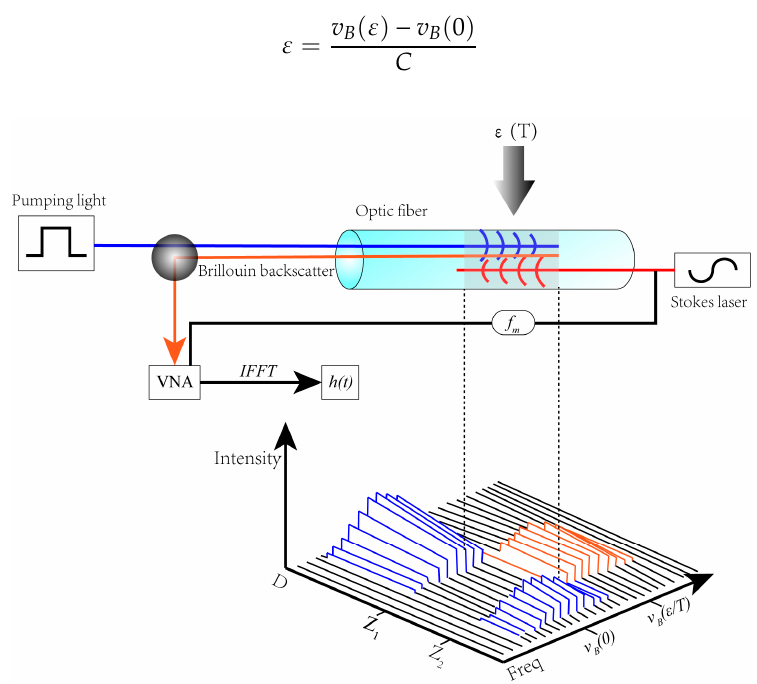
Figure 1. Principle of Brillouin optical time domain reflectometer (BOTDR) distributed optical fiber testing technology [38].